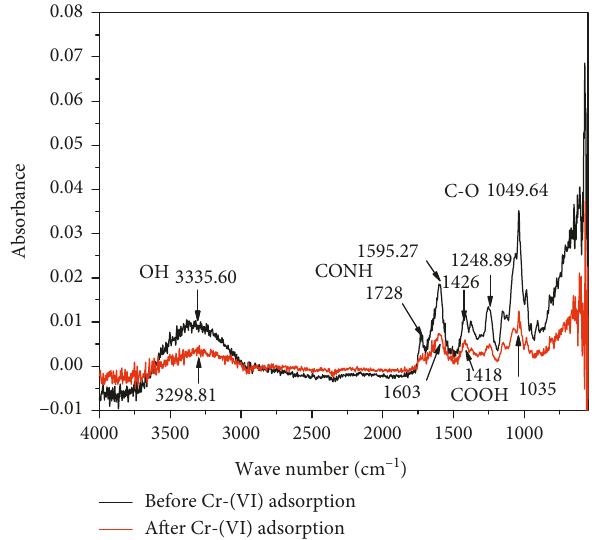
Figure 2: FTIR spectra of Grewia spp. biopolymer.